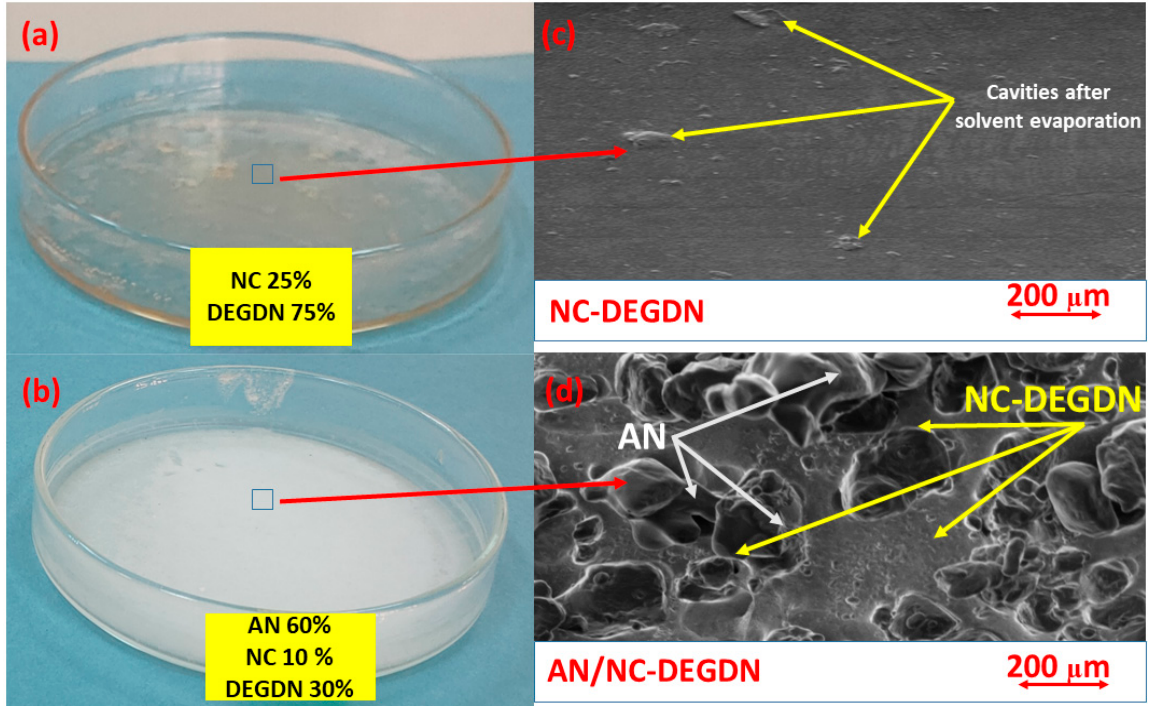
Figure 2. ( a ) NC-DEGDN composite film; ( b ) AN/NC-DEGDN composite film; SEM images of (( c ) NC-DEGDN mixture, ( d ) AN/NC-DEGDN mixture).